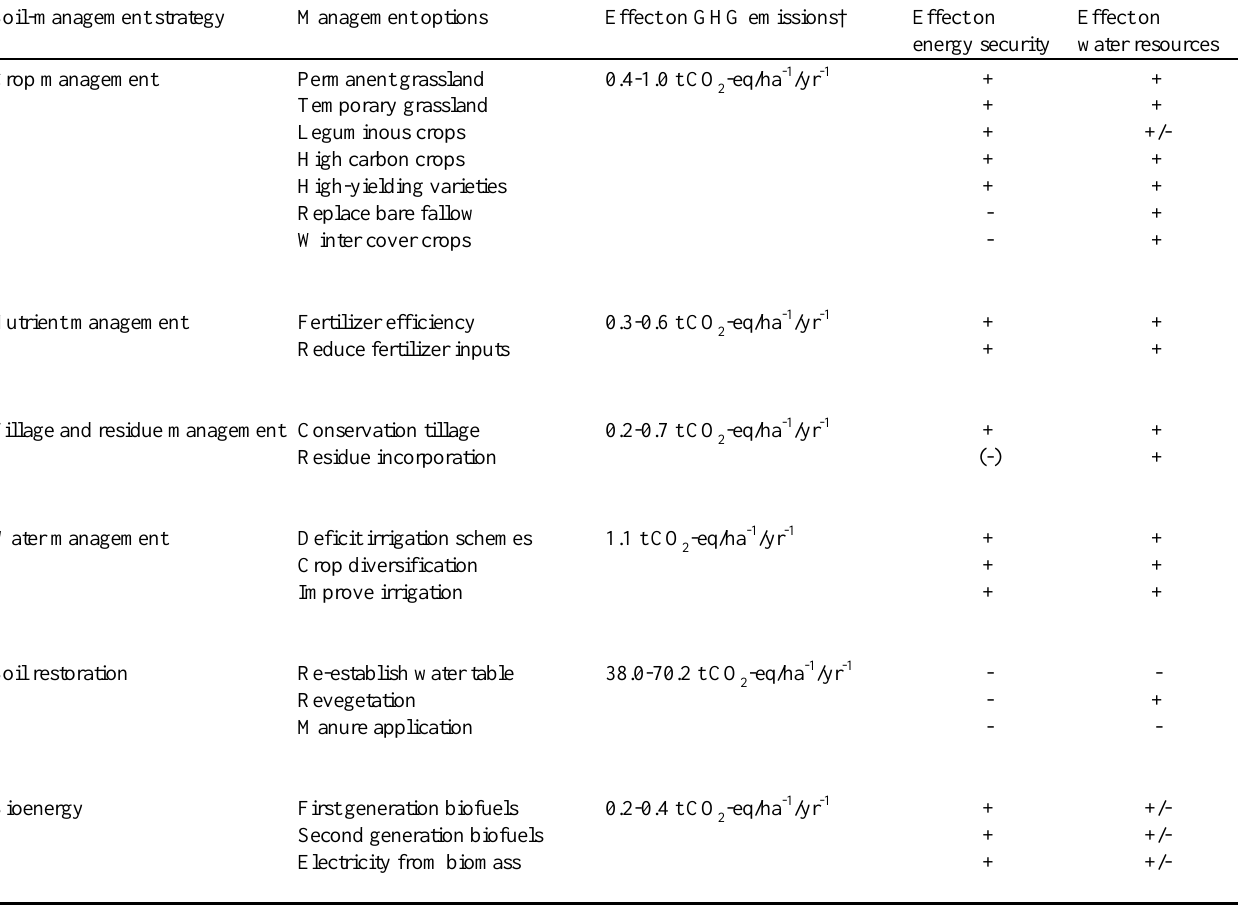
Table 1. Effects of GHG-mitigating soil-management strategies on energy security and water resources. Soil-management